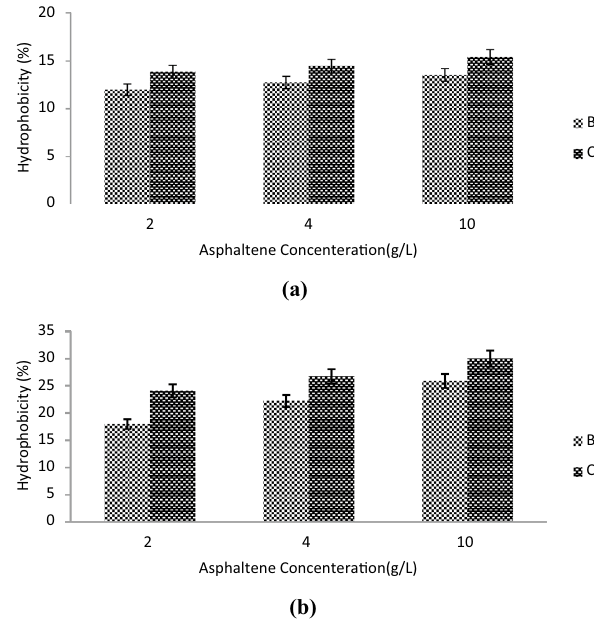
Fig. 8 Hydrophobicity of two types of microorganisms at different initial Kuh-e-Mond asphaltene concentrations: a without SDBS pres- ence and b with SDBS presence